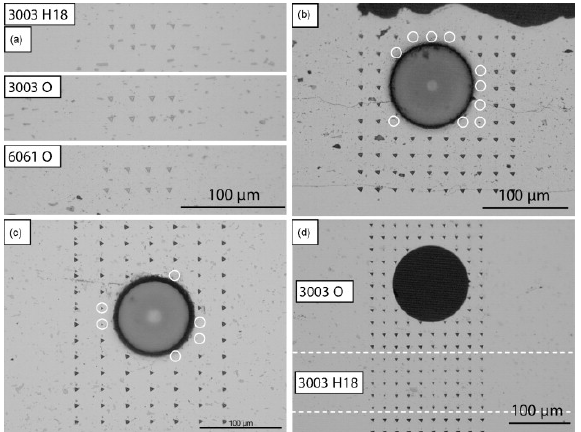
Figure 11. Microstructures of original foils and fiber embedded samples after nanoindentation: ( a ) original foils; ( b ) SiC fibers embedded in 6061 O; ( c ) SiC fibers embedded in 3003 O; and ( d ) a single mode optical fiber embedded in 3003 H18 and 3003 O (foil width direction: horizontal) [51].